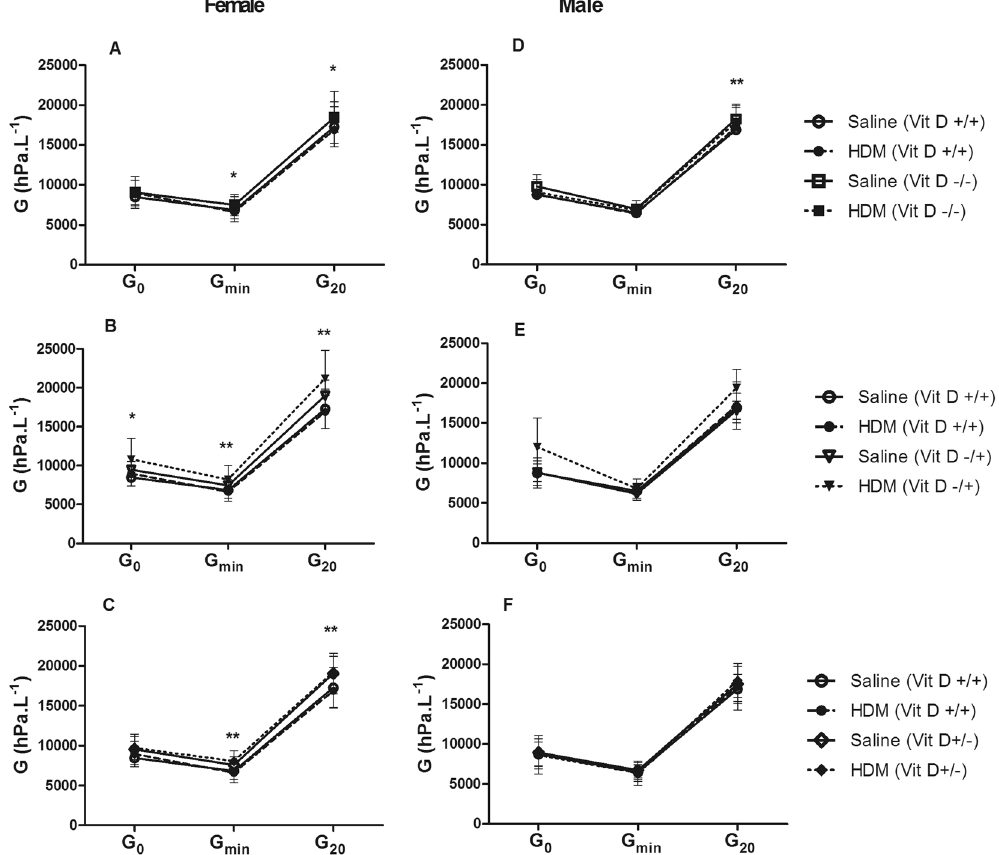
D + / + ), whole-life vitamin D deficient (Vit D − / − ; A , D ), in utero vitamin D deficient (Vit D − / + ; B , E ) or post-natal vitamin D deficient (Vit D + / − ; C , F ). Data are presented as mean (SD), n = 9–13 for each